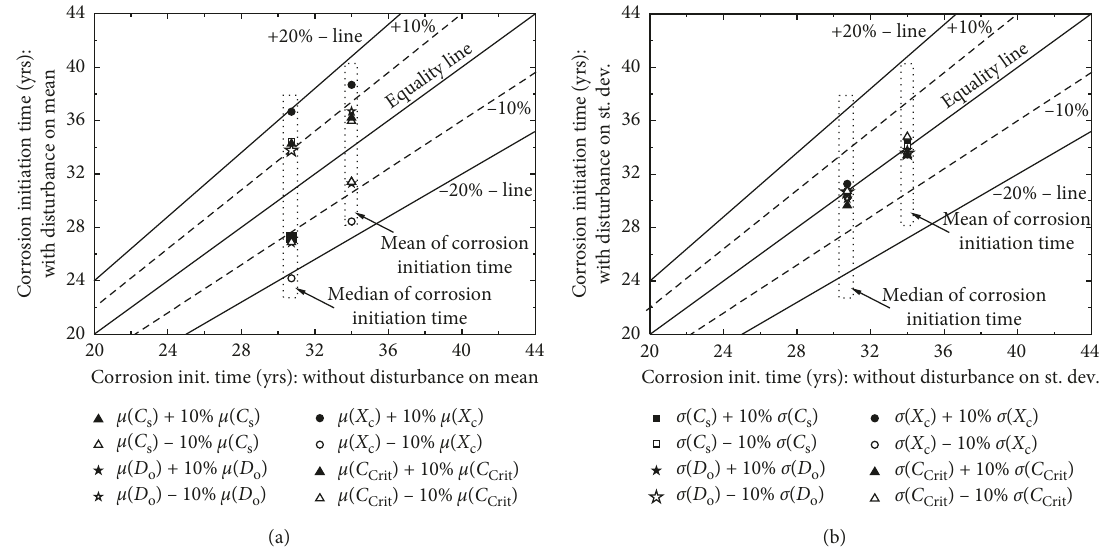
Figure 12: Sensitivity to mean and median of corrosion initiation time. (a) Effect of the mean of four random variables. (b) Effect of the standard deviation of four random